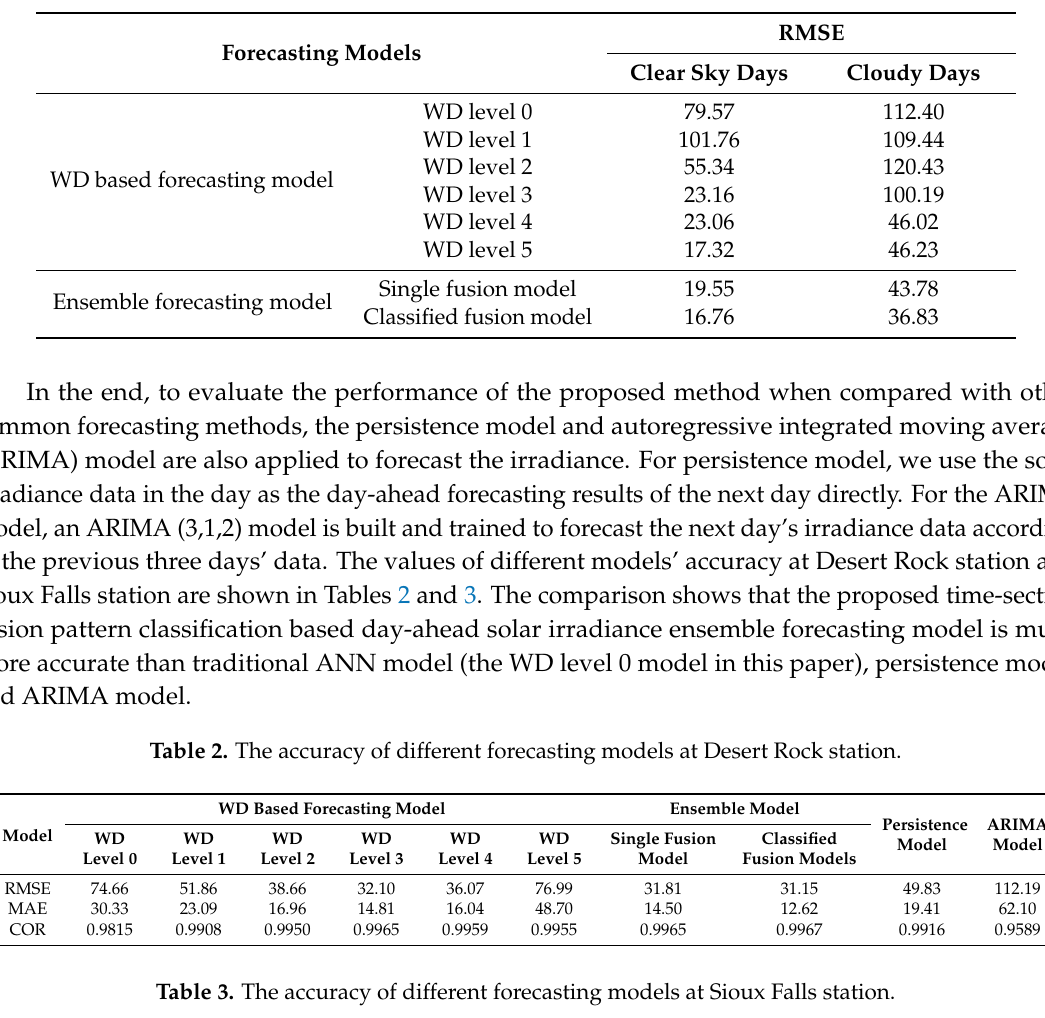
Table 3. The accuracy of different forecasting models at Sioux Falls station.